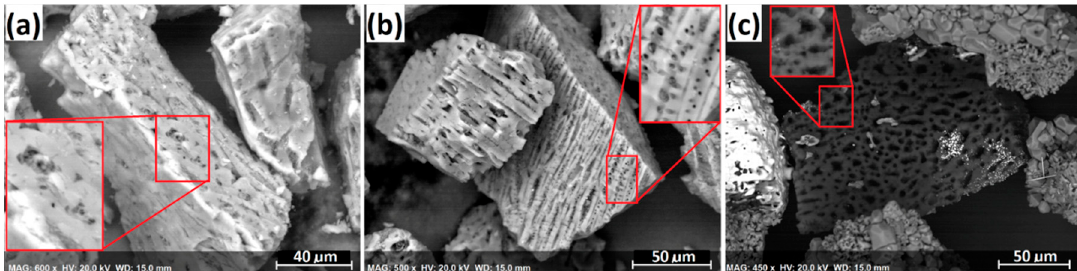
Figure 19. ( a ) Charcoal; ( b ) calcined charcoal showing the presence of micropores; and ( c ) residual charcoal in the segregation reduction product.